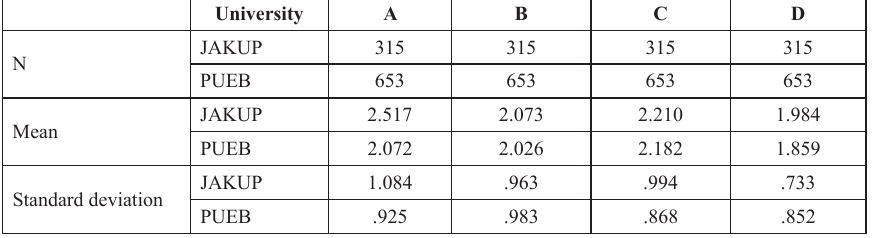
Table 8. Descriptive statistics – Attitudes towards the researched aspects of online learning from the university perspective, ordinal variables